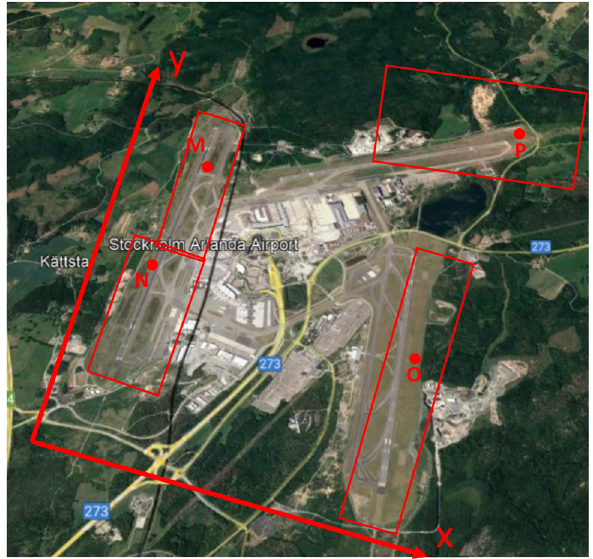
Figure 2: The local 2D coordinate system, ANs and search areas